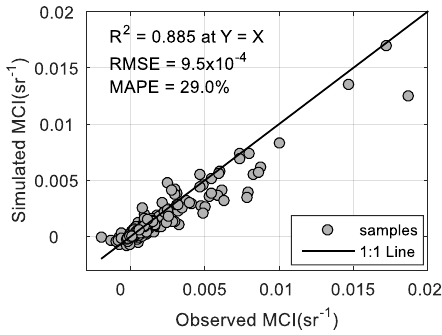
Figure 2. Comparison of in situ and Ecolight simulated MCI. N = 246, as described in Table